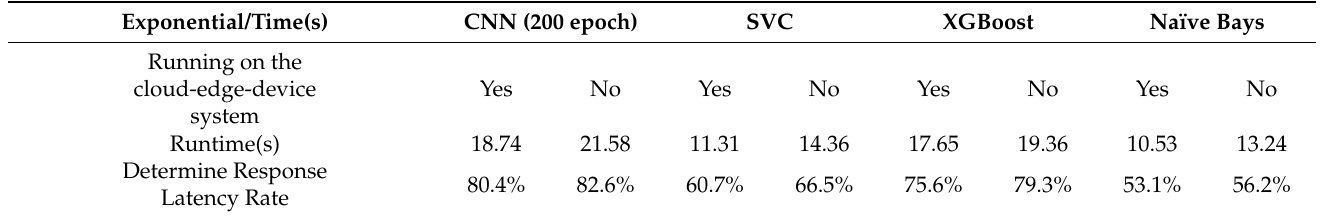
Table 4. The response times of our two calculation modes are compared, and the comparison results are as follows.